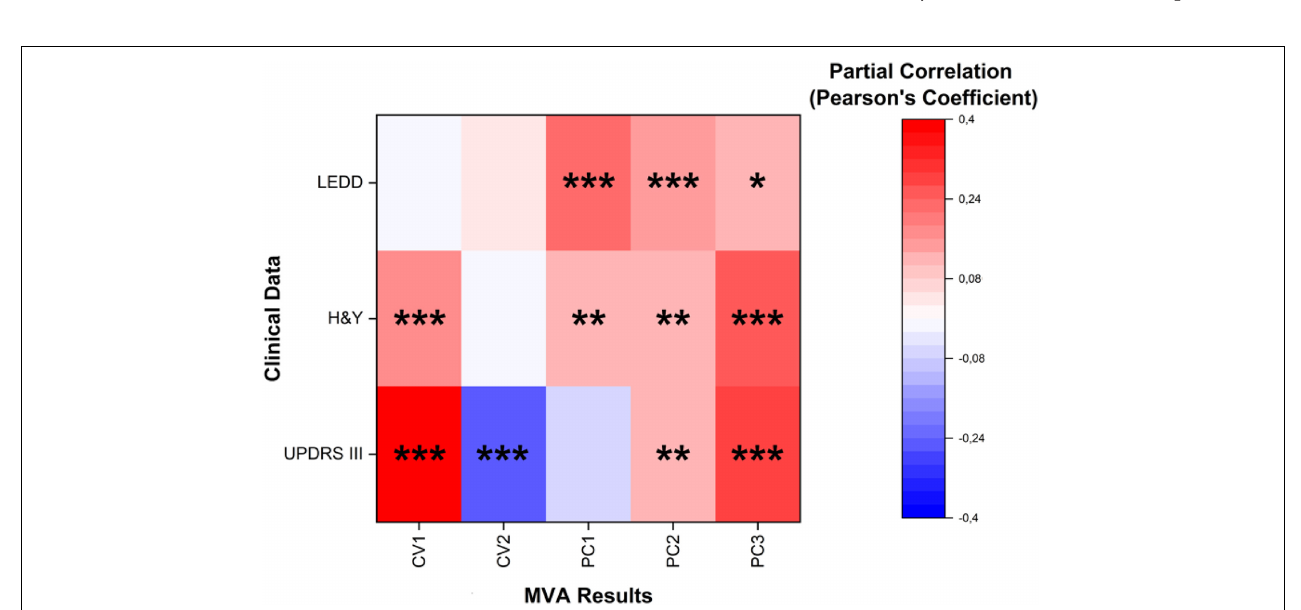
Figure 7 | Heat map representing the partial correlation (Pearson’s coefficients) with the relative significance of Canonical Variables 1 and 2 (CV1 and CV2) and Principal Components 1, 2, and 3 (PC1, PC2, and PC3) correlated with levodopa equivalent daily doses (LEDD), Hoehn and Yahr (H&Y) stages and Unified Parkinson’s Disease Rating Scale (UPDRS) motor scales (III). Age, sex, and behavioral parameters were used as control covariates for the partial correlation. * p < 0.05, ** p < 0.01, and *** p < 0.001, Pearson’s test.